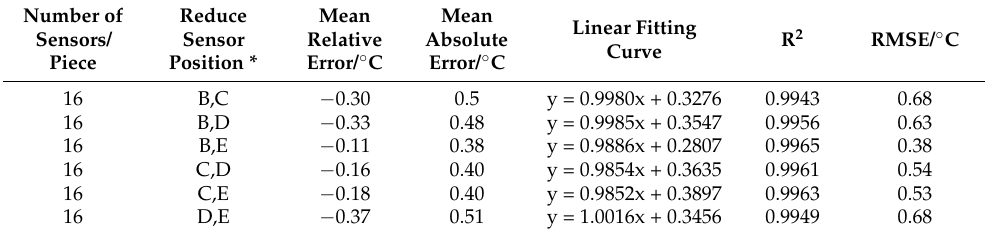
Table 6. Linear correlation analysis results after reducing 8 sensors.